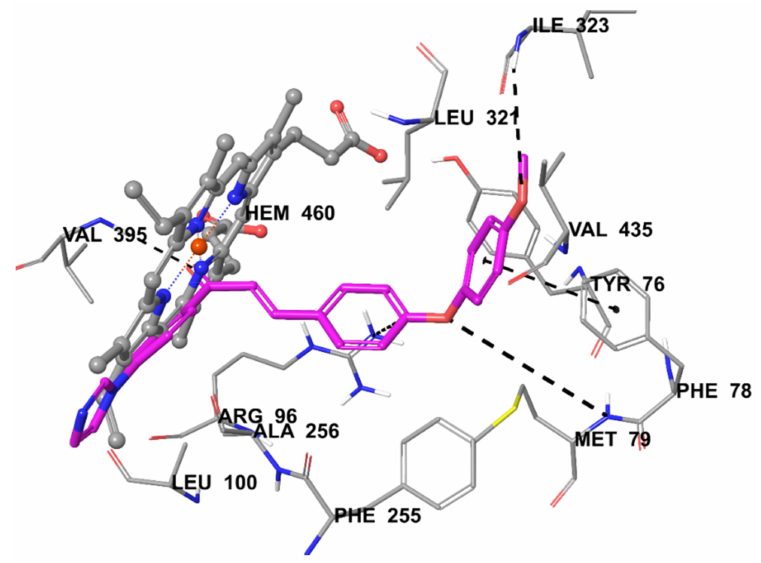
Figure 2. The interacting mode of Compound 3c in the active region of 14-alpha-sterol demethylase. The inhibitor is colored with purple and HEM with